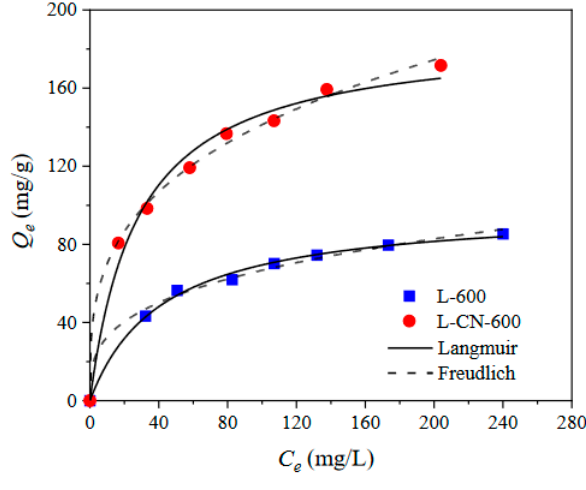
Figure 10. Adsorption isotherm curves of lignite-based porous carbons. Adsorption conditions: m / v = 0.4 g/L, 20 °C, t = 120 min. Table 6. Langmuir and Freundlich adsorption isotherm parameters for L-600 and L-CN-600 at 20 °C. Adsorbent